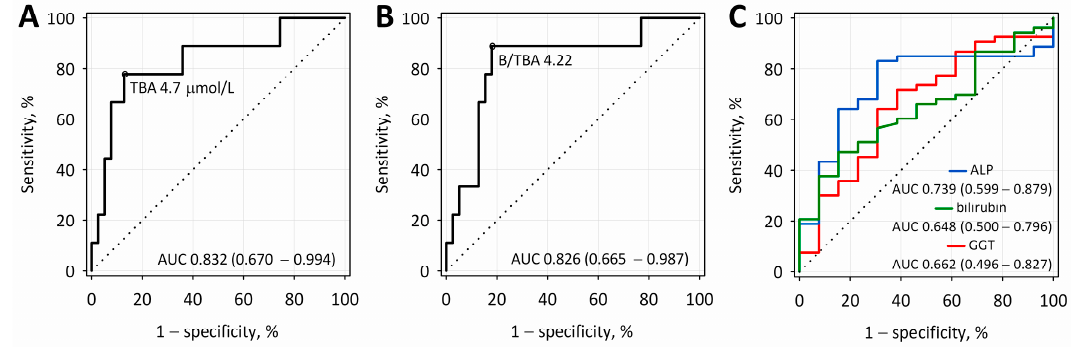
Figure 3. Receiver operating characteristic (ROC) curves for TBA ( A ); and B/TBA ( B ) for the diagnosis of biliary etiology in patients with acute pancreatitis at 24 h from the onset of symptoms. For comparison, ROC curves are presented for ALP, bilirubin, and GGT measured at the same time point ( C ). AUC: area under the ROC curve. Table 3. Diagnostic utility of TBA serum concentration and the B/TBA ratio for the diagnosis of biliary etiology of acute pancreatitis at 24 h from the onset of symptoms. For comparison, diagnostic utility of ALP, bilirubin, and GGT at the same time point is presented.